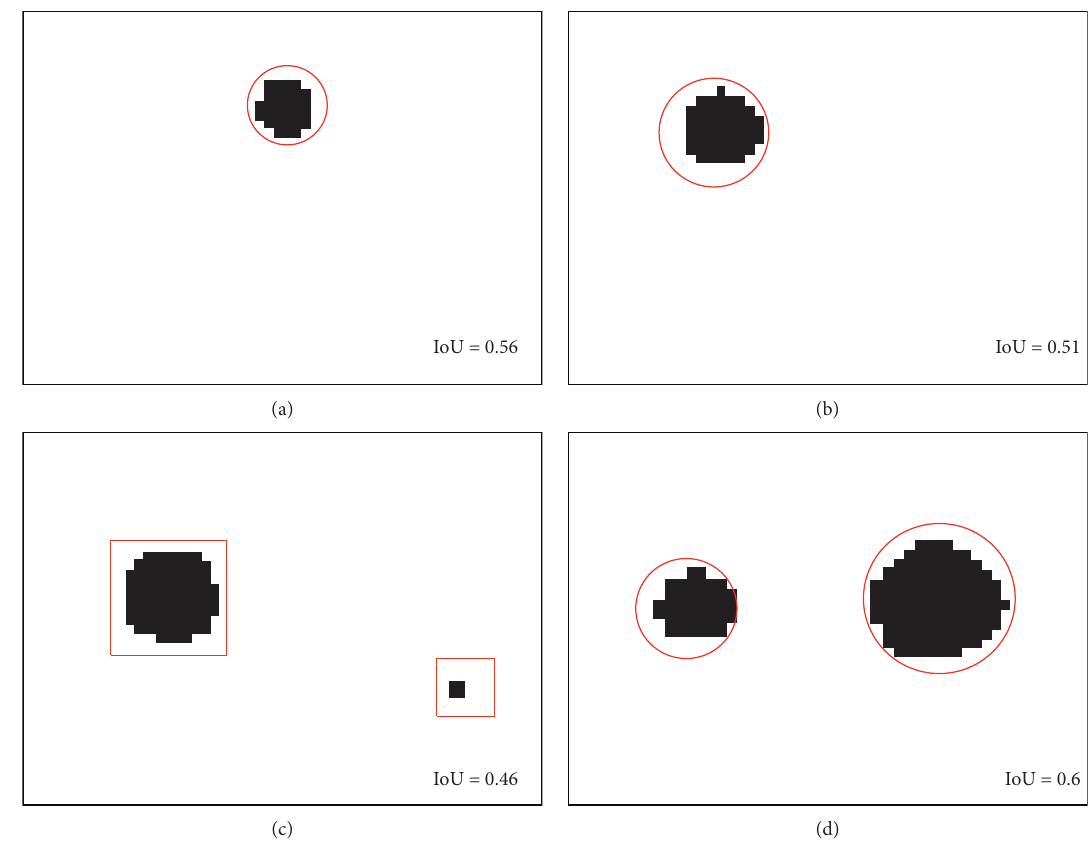
Figure 12: Experimental damage identified with the proposed CNN-based approach. Normalized damage sizes: (a) 0.09 (Case 1), (b) 0.12 (Case 2), (c) 0.14 and 0.07 (Case 3), and (d) 0.11 and 0.17 (Case 4). The red circles/squares denote the true damage